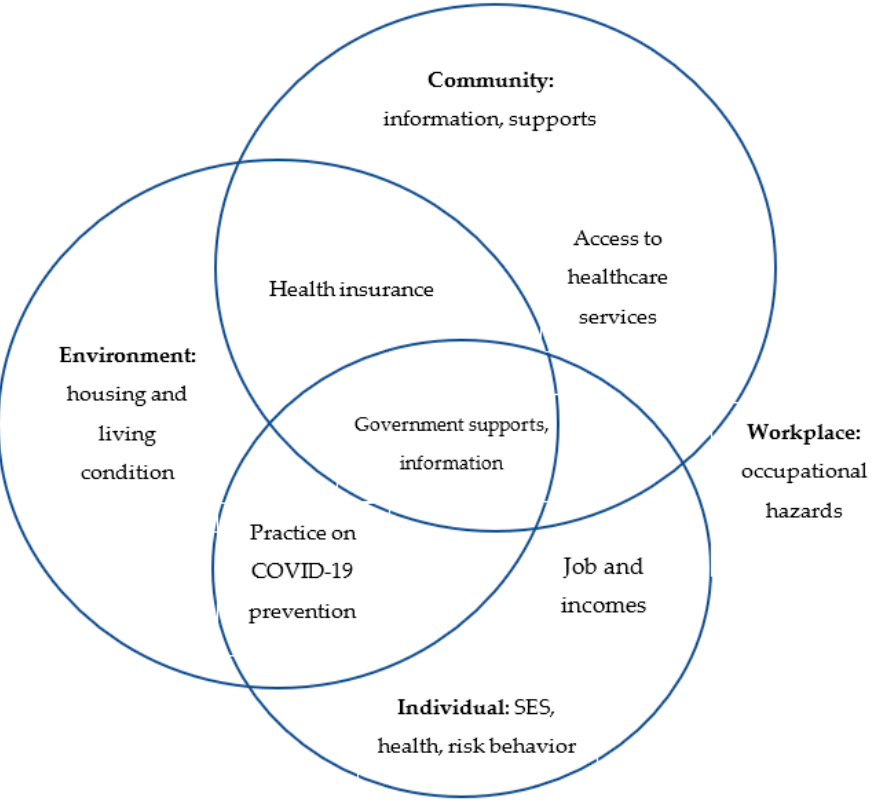
Figure 1. Conceptual Framework in combating COVID-19 for migrant workers. (The framework developed and adapted from Fox [22] and Aladmad [23]).